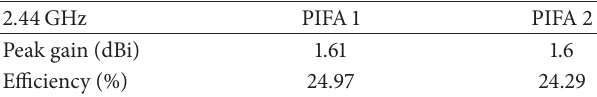
Table 2: Measured peak gain and radiation